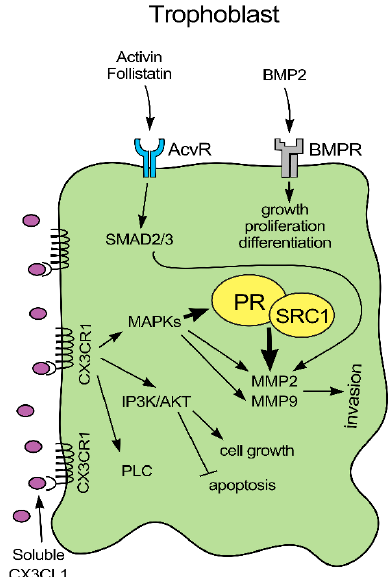
Figure 6. Mechanism of action of fractalkine on JEG-3 trophoblast cells Fractalkine binds to its cognate receptor on the surface of trophoblast cells activating MAPK and AKT pathways. MAPKs can phosphorylate PR on serine amino acid residue increasing its activity. Secreted activin may bind